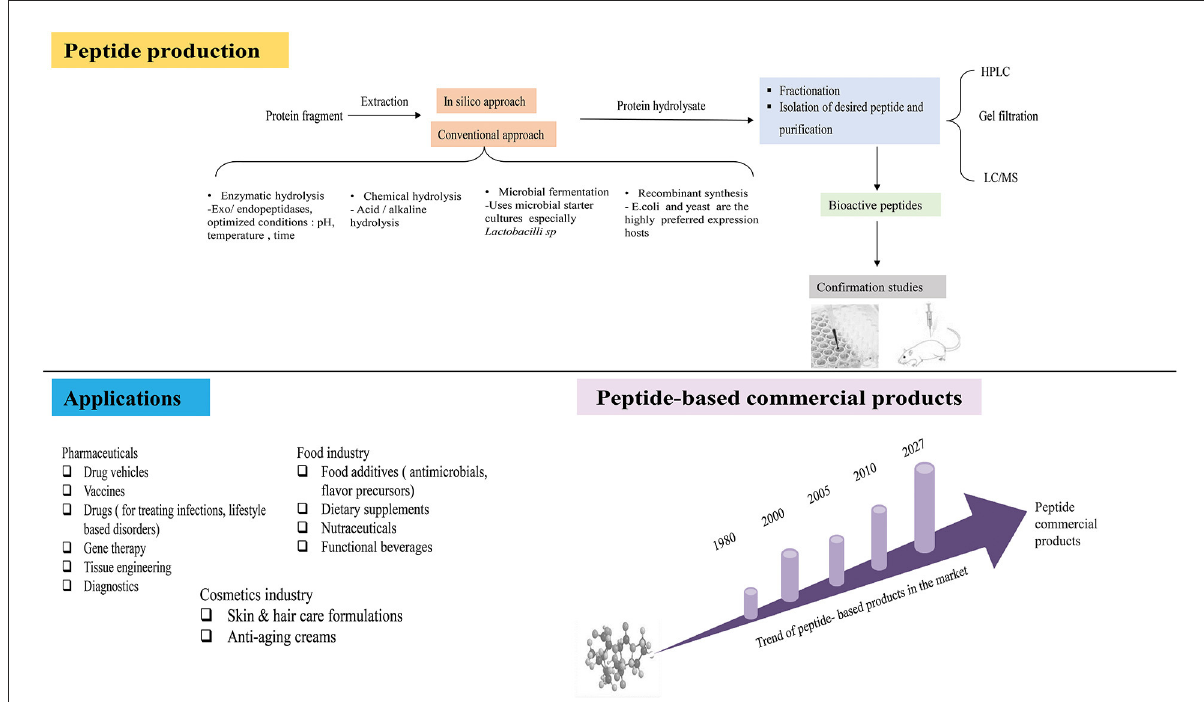
FIGURE1 Illustration showing the experimental flow of peptide production, application of peptides and trend of commercial peptide